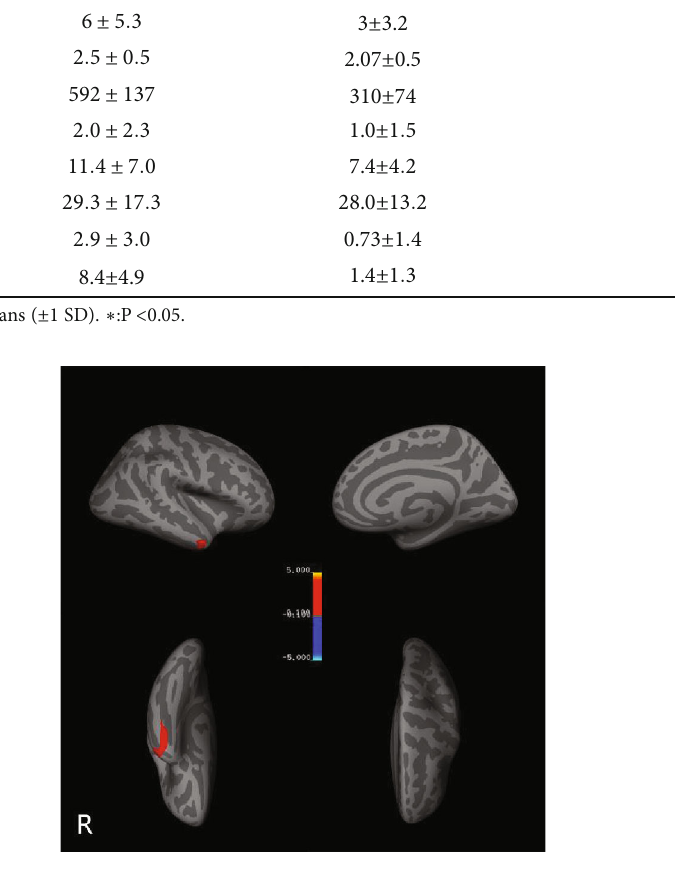
Figure 1: Signi fi cant reduction of cortical thickness was discovered in middle temporal gyrus (MTG) of right hemisphere at global level.